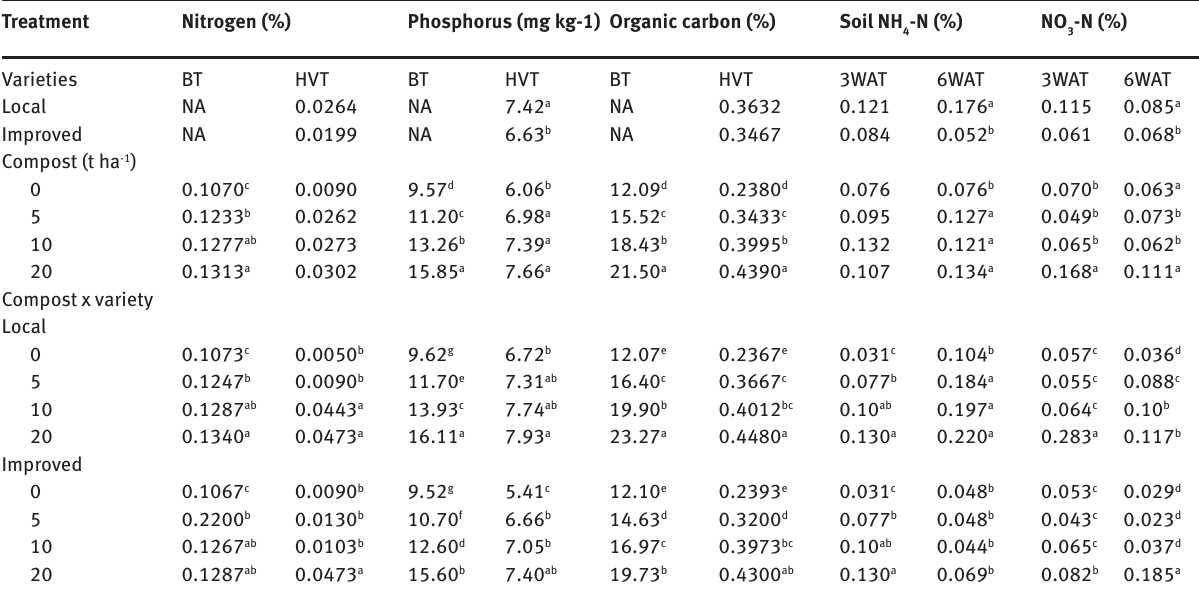
Table 4: Combined analysis of soil chemical properties at 2 sampling periods in pot experiments amended with 4 rates of compost and 2 tomato varieties